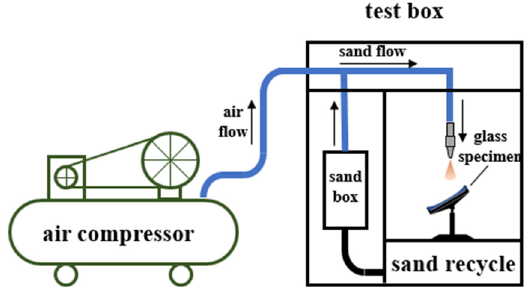
Figure 2. Schematic drawing of the sandblasting equipment.